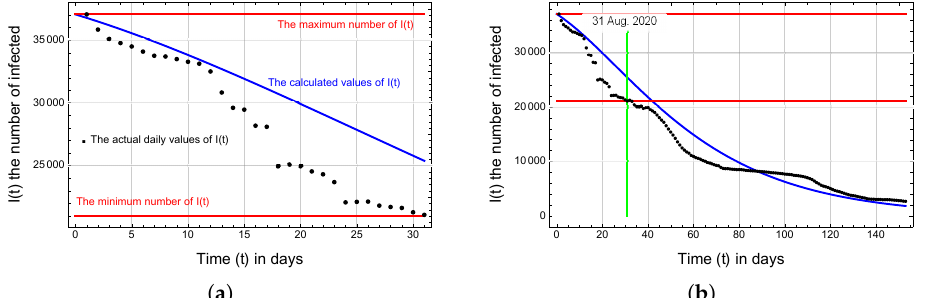
Figure 7. The behavior of the daily infected active cases due to parameter determined from the data of Augus. ( a ) Calculated and actual daily infected active cases along small period of time (August). ( b ) Calculated and actual daily infected active cases along long period of time (from August to end of